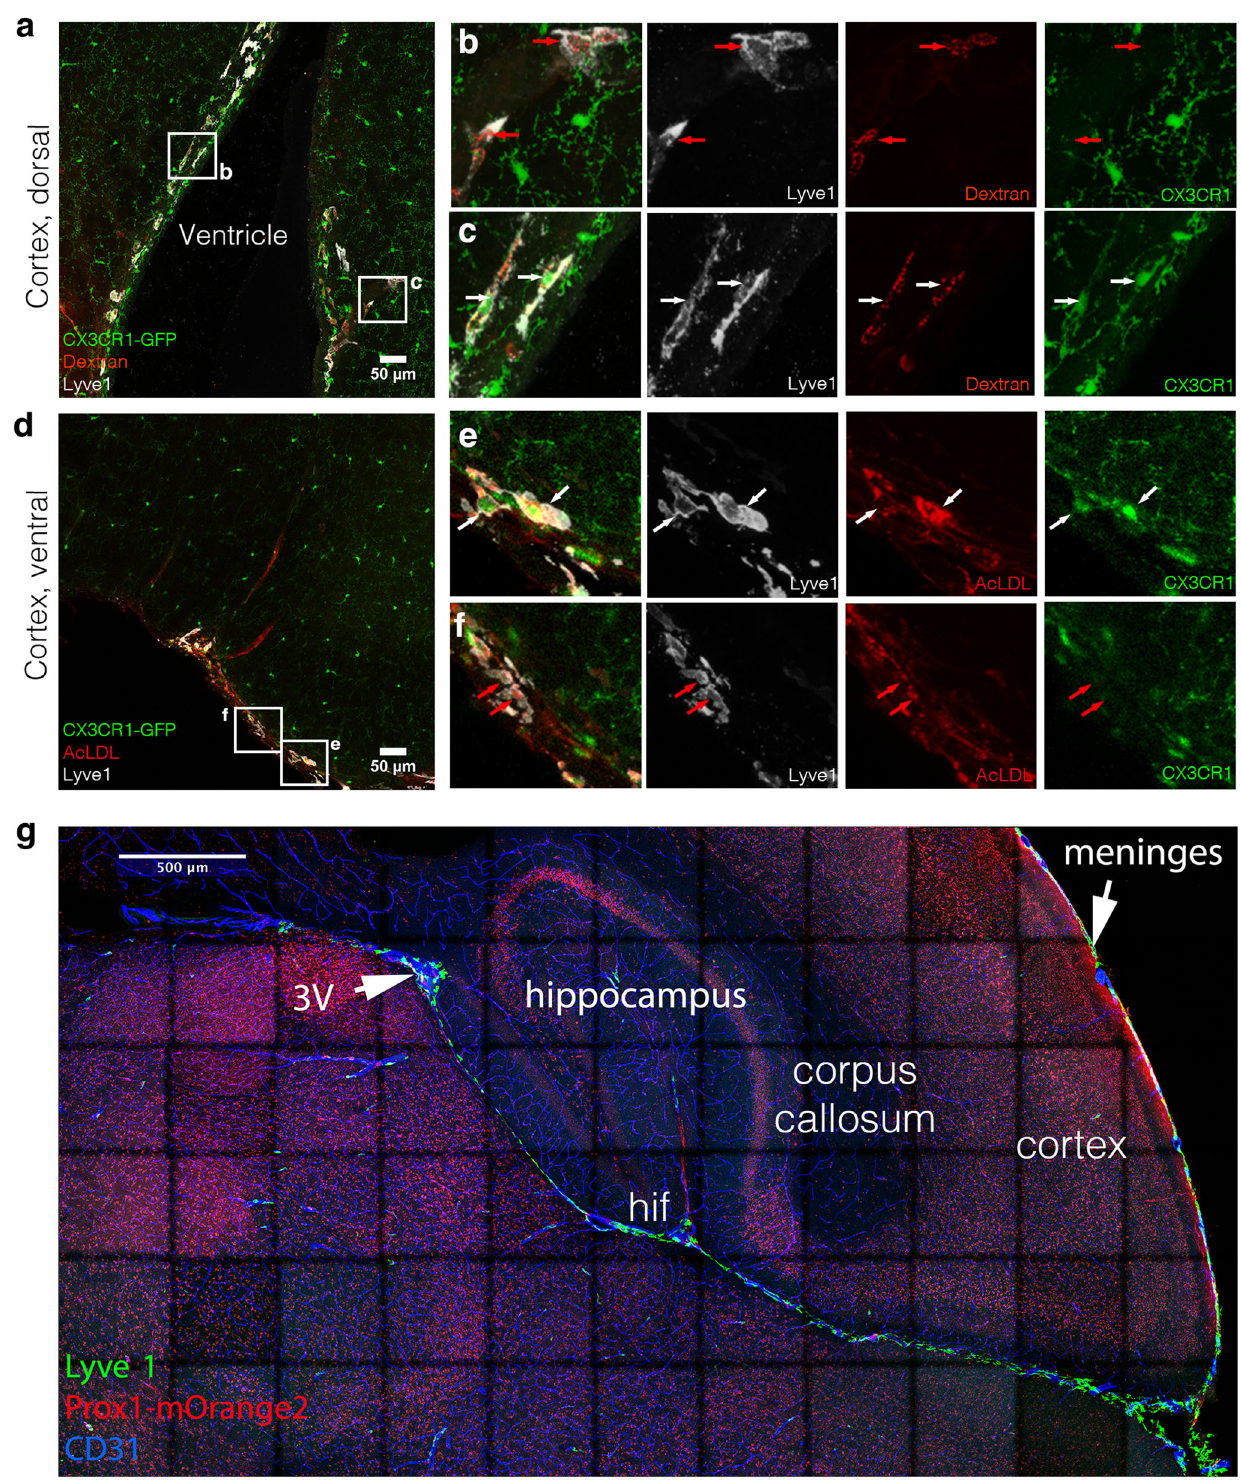
Fig. 6 | CX3CR1 – pvM share phagocytic functioning with CX3CR1 + pvM. a – c Cx3cr1 GFP mouse brains were injected intra-ventricular with Dextran-Alexa647 (37 µ m maximum intensity projection) ( n =3) and d – f Acetylated-LDL-Alexa594 (42 µ m maximum intensity projection) ( n =3). Ten minutes after injection, mice were euthanized and brains dissected. Confocal analysis on brain sections shows Lyve1 (white), Dyes (red), and CX3CR1 (green). The unconventional pvMs